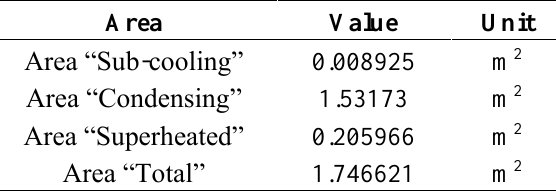
Table 15. Area of heat